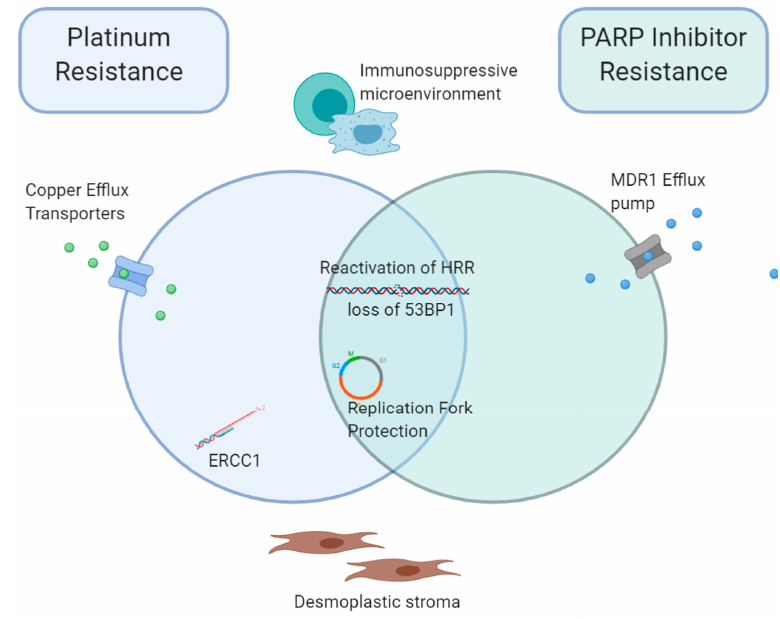
Figure 2. Overlapping mechanisms of resistance to Platinum and PARP-inhibitor treatment. Platinum and PARPi demonstrate distinct and overlapping mechanisms of acquired treatment resistance. Whilst both demonstrate reactivation of HRR and loss of 53BP1, and replication fork protection promoting progression through the cell cycle, platinum resistance is additionally associated with defects in the NER pathway, including increased ERCC1 activity. Reduced intracellular drug accumulation is achieved via copper transporters for platinum, and MDR1 drug e ffl ux pump for PARPi. In both instances, an immunosuppressive microenvironment and desmoplastic stroma likely contribute to tumour progression. Abbreviations; HRR, homologous recombination repair, MDR1, Multidrug Resistance Protein 1, ERCC1, DNA excision repair protein ERCC-1, PARPi, PARP